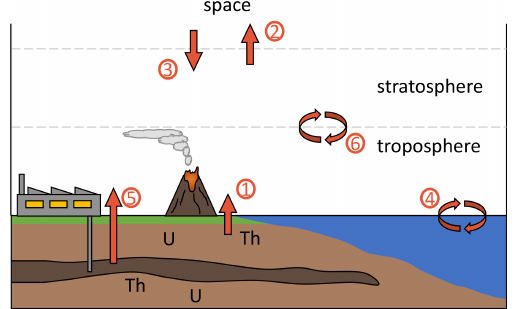
Figure 1. Schematic depiction of 4 He fluxes to and from the tropo- sphere. Different processes are numbered and listed in Table